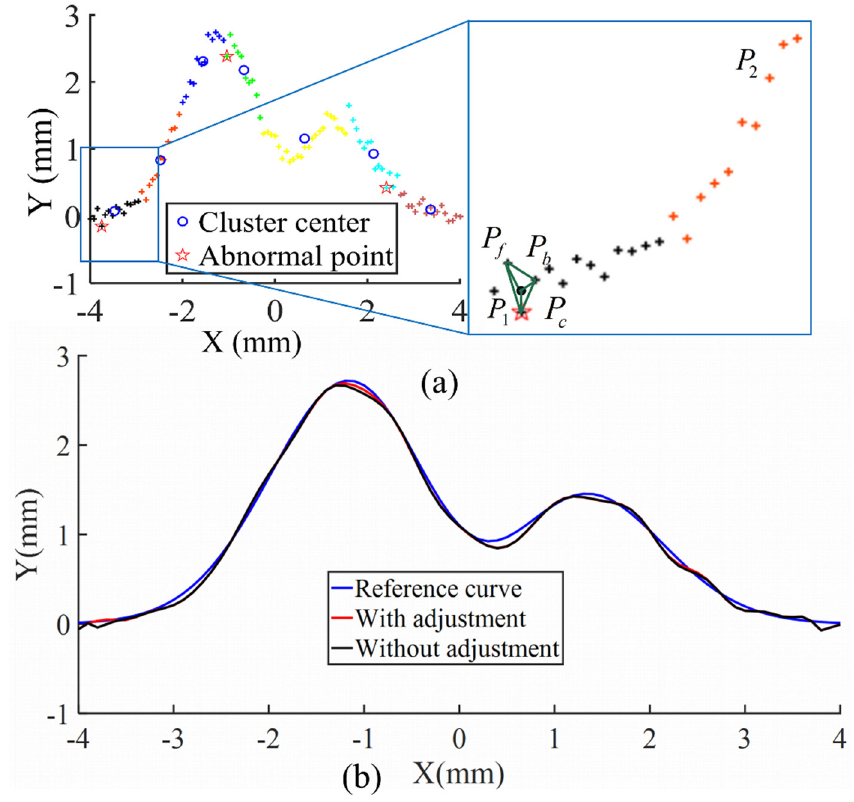
Figure 6. ( a ) Scheme of analysis of abnormal sample; ( b ) curve fitting results.